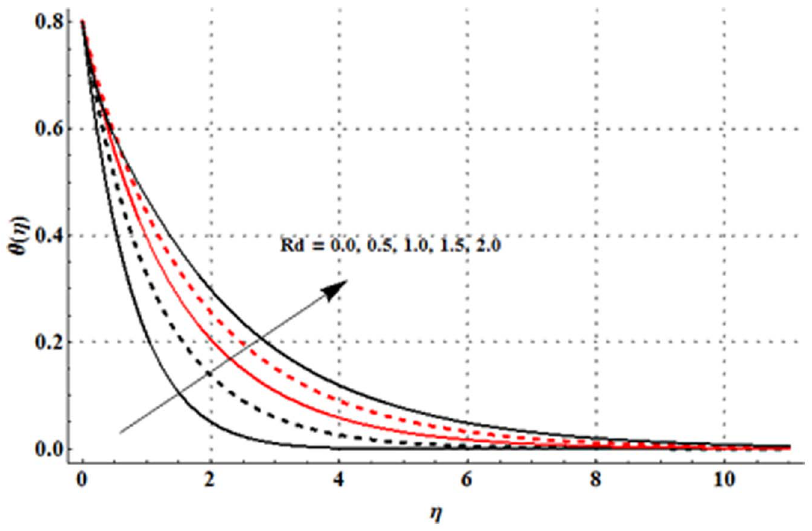
Figure 15. Influence of Rd on the temperature profile h ( g ) when M ~ 0 : 6, b ~ 0 : 4, l 1 ~ 0 : 5, l ~ 0 : 3 ~ N , Pr ~ 1 : 2, S ~ 0 : 2 ~ S (cid:2) and Sc ~ 1 : 0 :